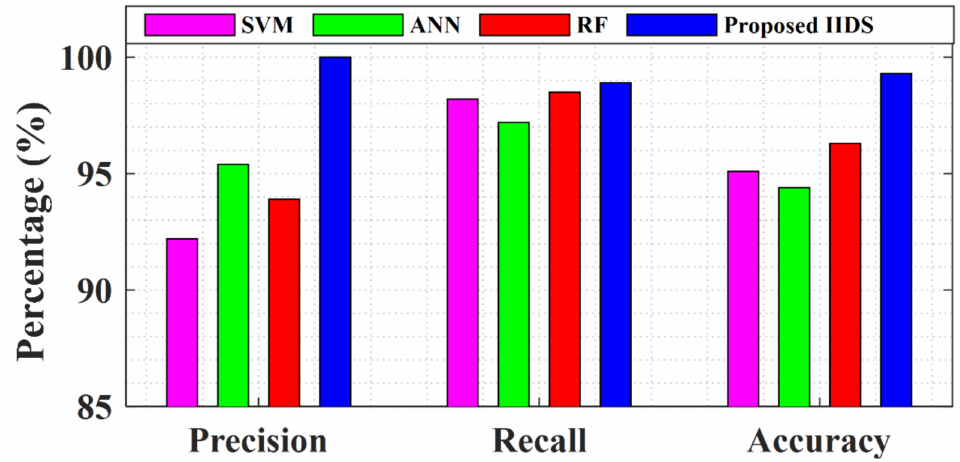
Figure 5. Performance of the proposed IIDS on the IEC microgrid.